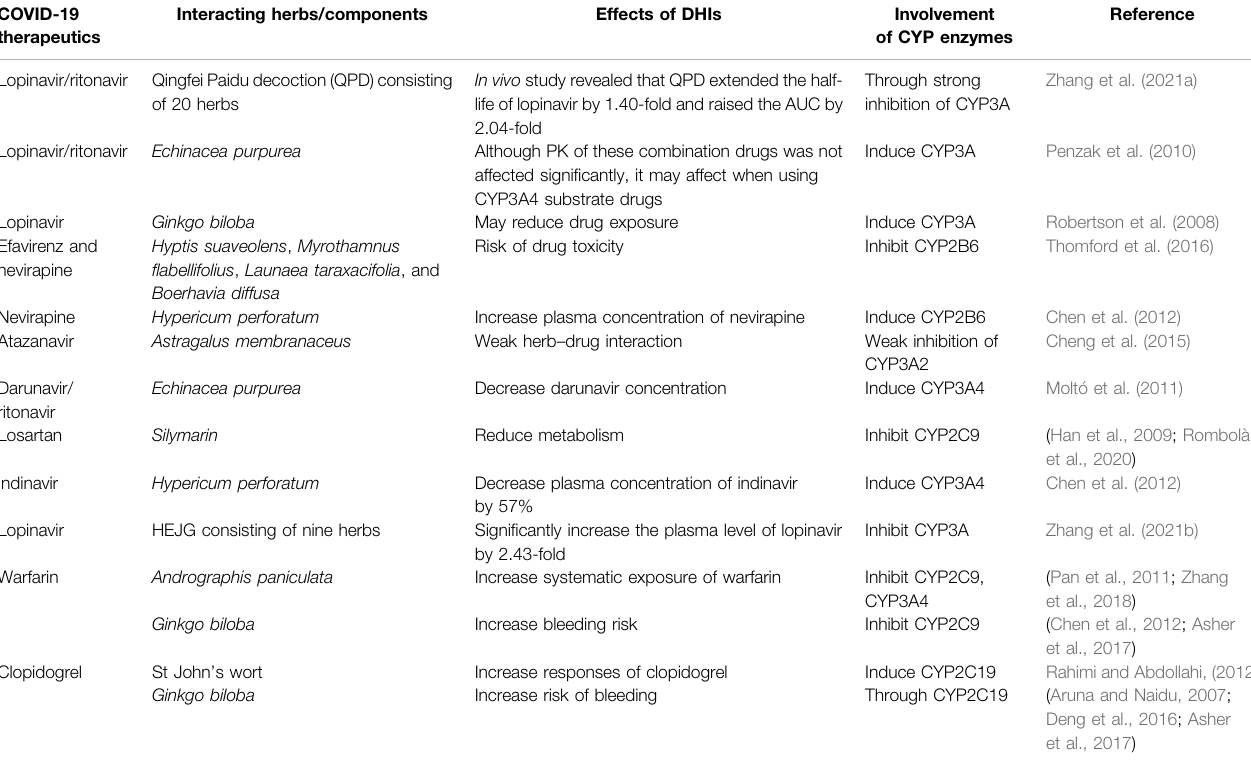
TABLE 9 | Potential DHIs of COVID-19 therapeutics and